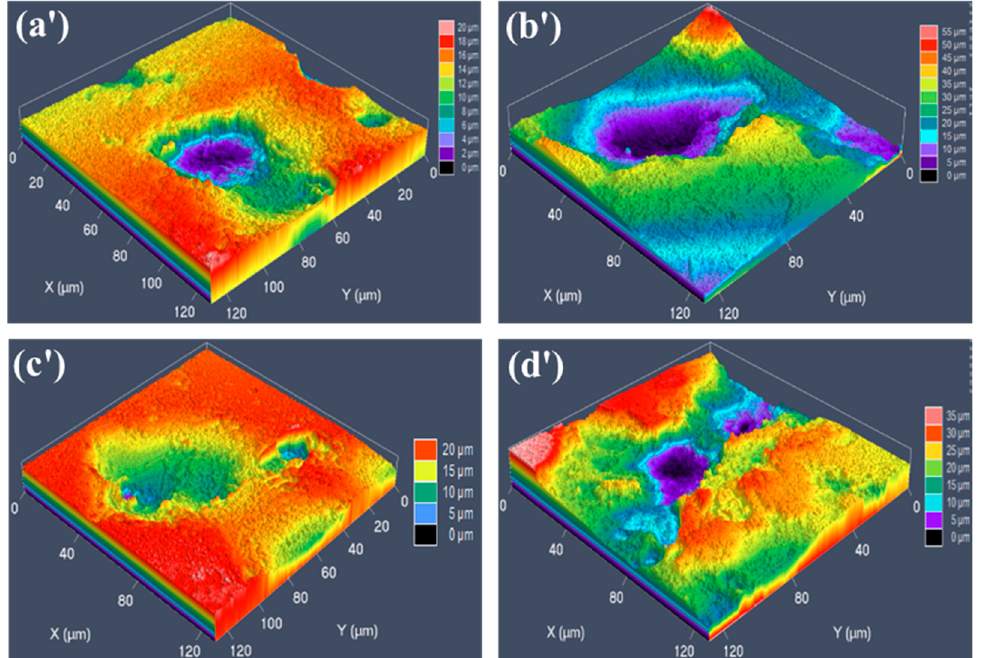
Figure 11. Three-dimensional corrosion morphology of the 35CrMoV steel: ( a’ ) 0.01 s − 1 , 850 °C; ( b’ )0.01 s − 1 , 1050 °C; ( c’ ) 10 s − 1 , 850 °C; ( d’ ) 10 s − 1 , 1050 °C.